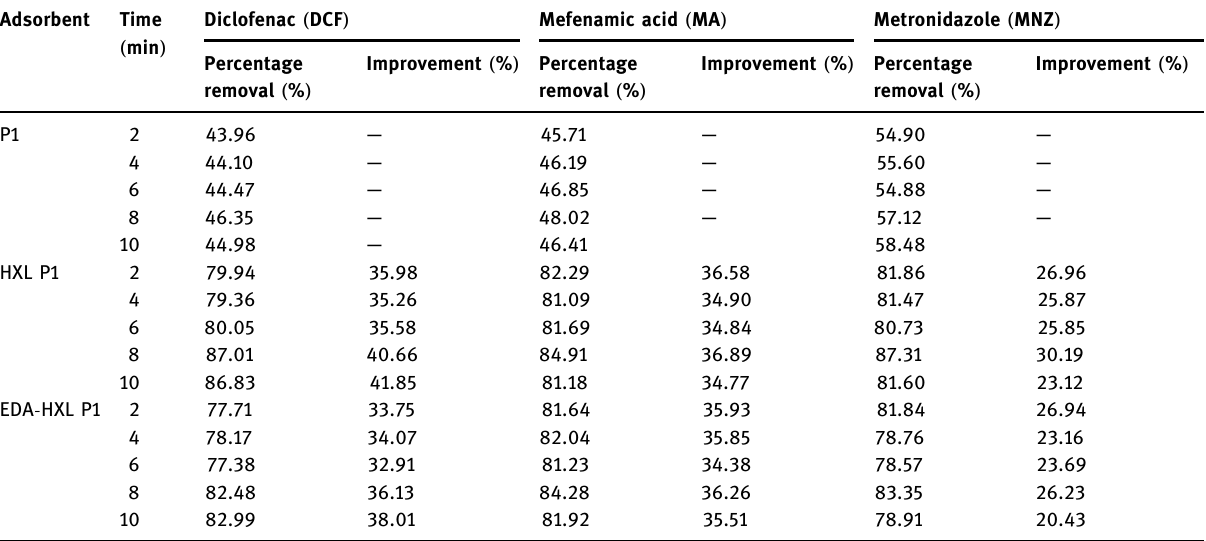
Table 4: Adsorption test of pharmaceuticals on P1, HXL P1, and EDA - HXL P1 terpolymers with variation of times Adsorbent